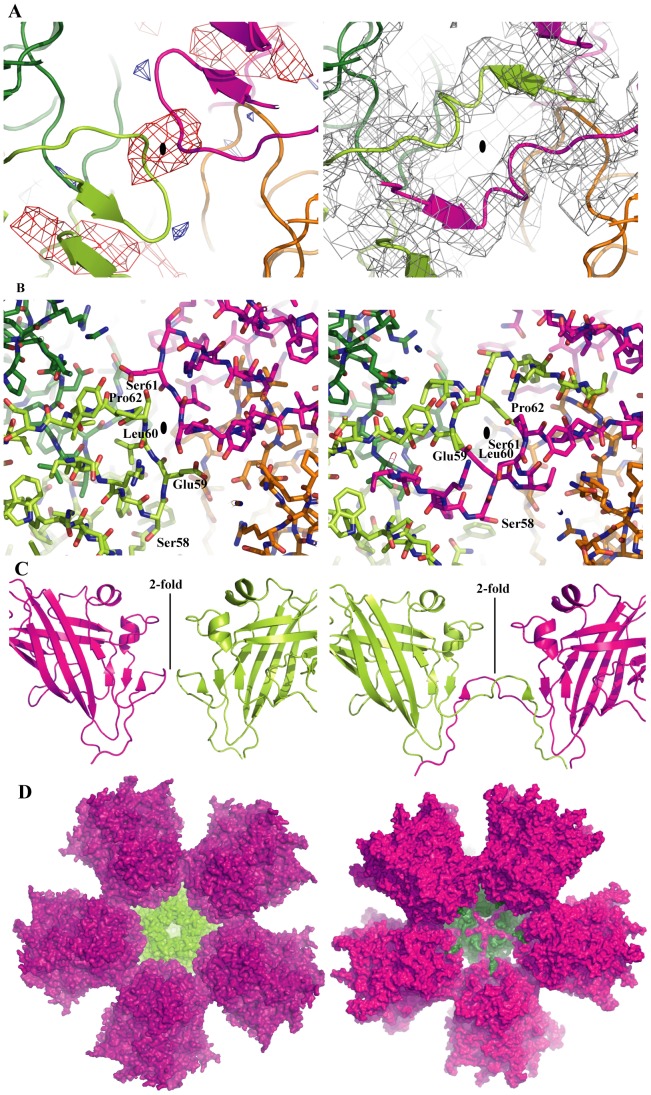
Ad3 Dd stabilization by strand-swapping.(A) Cartoon representation of the peptide backbone of the Dd without strand-swapping (left) and with strand-swapping (right), next to a 2-fold axis (small black oval). Residues contributed by one Pb are shown in dark green and light green, the ones contributed by the 2-fold related neighbor are shown in magenta and orange. Using model phases from the model without strand-swapping and experimental structure factor amplitudes from the cubic crystal form, 20-fold averaged Fo-Fc and 2Fo-Fc electron density has been calculated. On the left side the Fo-Fc electron density is shown (red, negative electron density; blue, positive electron density). The negative electron density indicates a part of the model not present in the crystal, showing the interruption of the strand due to strand-swapping. On the right side the 2Fo-Fc electron density shows a continuity of the electron density across the subunits suggesting strand-swapping. (B) The same models as in (A) are shown, using the same coloring scheme but stick representation. The non-swapped version on the left where residues 59ELS61 form a simple contact between adjacent Pbs corresponds to the situation in Ad2, whereas the right panel shows the extensive interaction due to the strand-swapping as observed for Ad3. (C) Side-view of the contacts next to a 2-fold symmetry axis of the Dd showing the model of two Pb molecules without swapped N-termini on the left (as in Ad2) and with swapped N-termini on the right (Ad3). (D) Inside view of a half Dd (6 Pbs). The surface of the bottom Pb is shown in green, the five interacting Pbs are shown in magenta/violet. The left panel shows the structure for Ad2 without strand-swapping, the right panel shows the 5 N-terminal extensions interacting through strand-swapping.